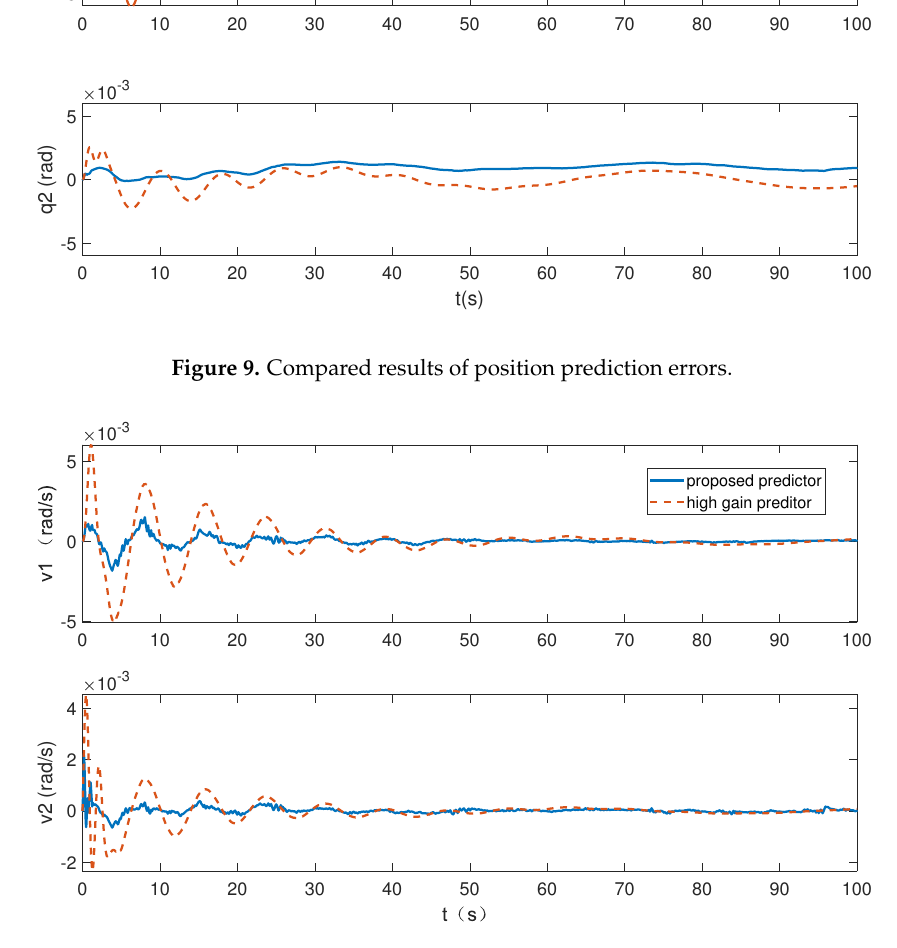
Figure 10. Compared results of velocity prediction